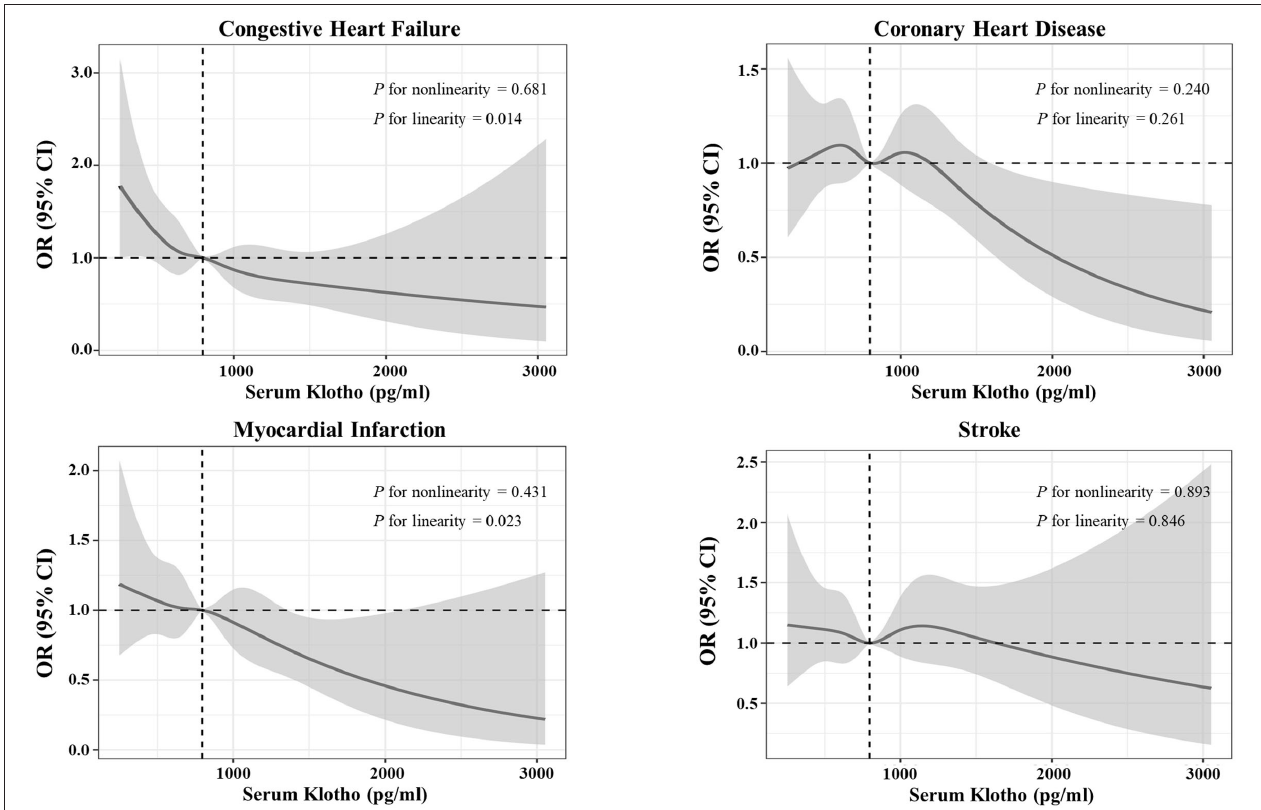
FIGURE 4 | Restricted cubic spine curves for the associations between serum soluble α -Klotho and the four specific cardiovascular diseases. Adjusted odds ratio ( OR ) (solid lines) and 95% confidence intervals (gray shadow) for congestive heart failure (CHF), coronary heart disease, myocardial infarction (MI), and stroke after controlling covariates in Table 1 . Spines were examined in the fully adjusted model with the best placed knots at the 5 th , 35 th , 65 th , and 95 th percentiles of α -Klotho